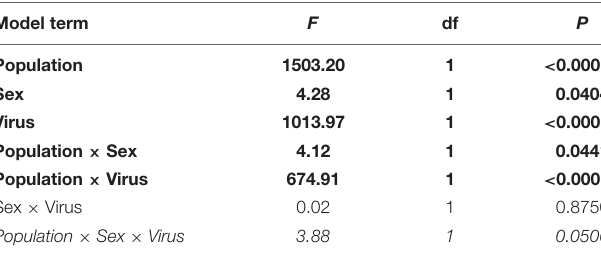
TABLE 3 | Model terms and statistics from generalized linear models for log-transformed absolute abundance (number of viral copies) of cricket iridovirus (CrIV) and Acheta domesticus densovirus (AdDNV) detected across two populations (“Healthy” and “Diseased”) of male and female adult reared Gryllodes sigillatus